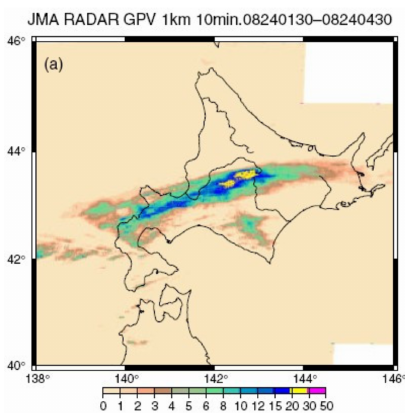
Figure 3. Spatial distribution of 3-h average rainfall intensity (mm / h) from derived from C-band AMeDAS rainfall radar over Hokkaido Island on 24 August 2010 at 01:30–04:30 UTC